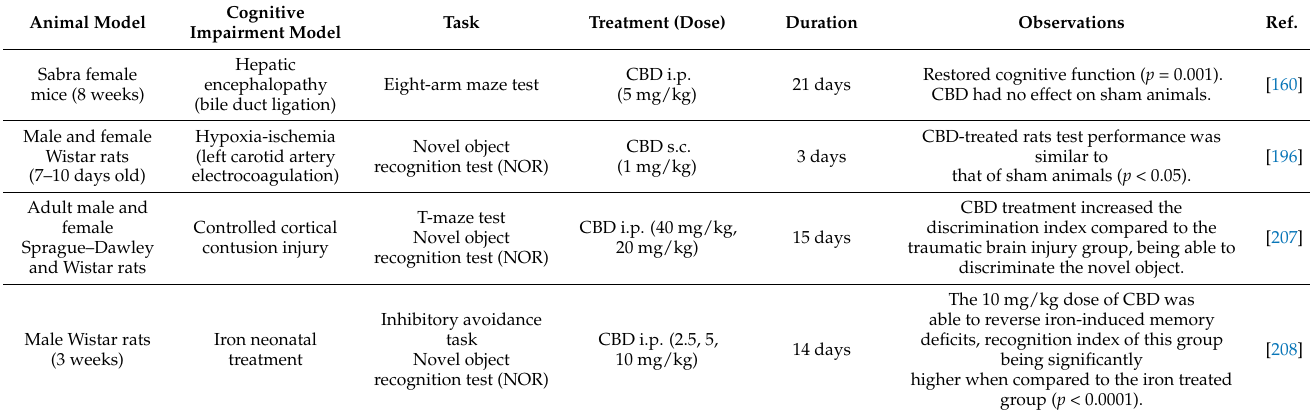
Table 1. Experimental results of cognitive behavioral tests performed on